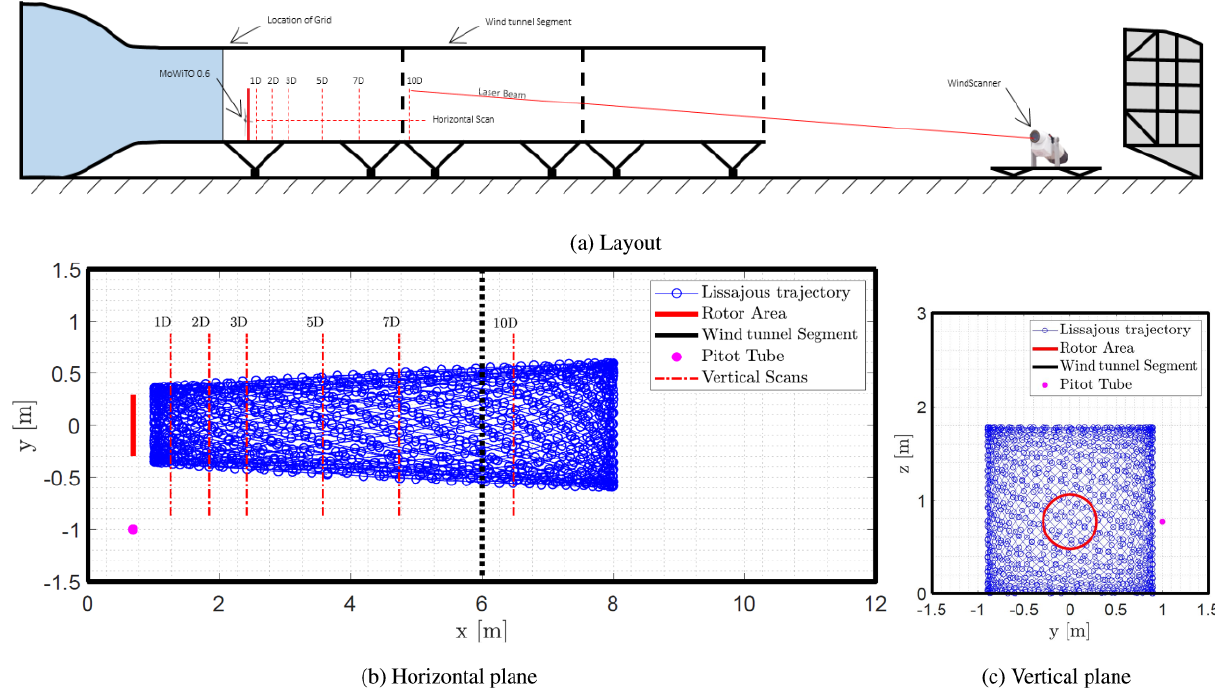
Figure 1. The layout of the wind tunnel campaign and the corresponding lidar scans measuring the flow. A Lissajous trajectory is used to measure a horizontal plane behind the turbine with a duration t scan ≈ 22s per individual scan and a vertical plane with a duration of t scan ≈ 7–8s per individual scan. The blue dots indicate the individual measurement points along the trajectory of the laser beam.